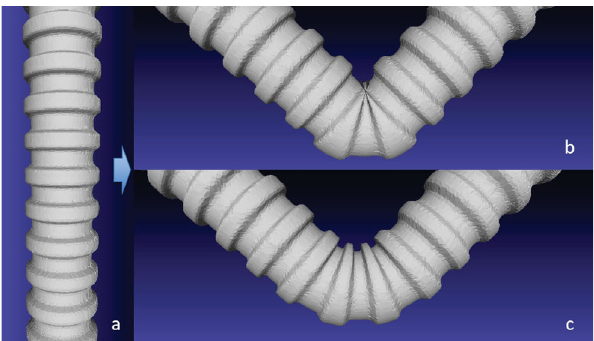
Fig. 4 Self-intersections between cross sections result in surface self-intersections. (a) Straight tube before bending; (b) tube bent using intersecting cross sections; (c) tube bent using non-intersecting cross